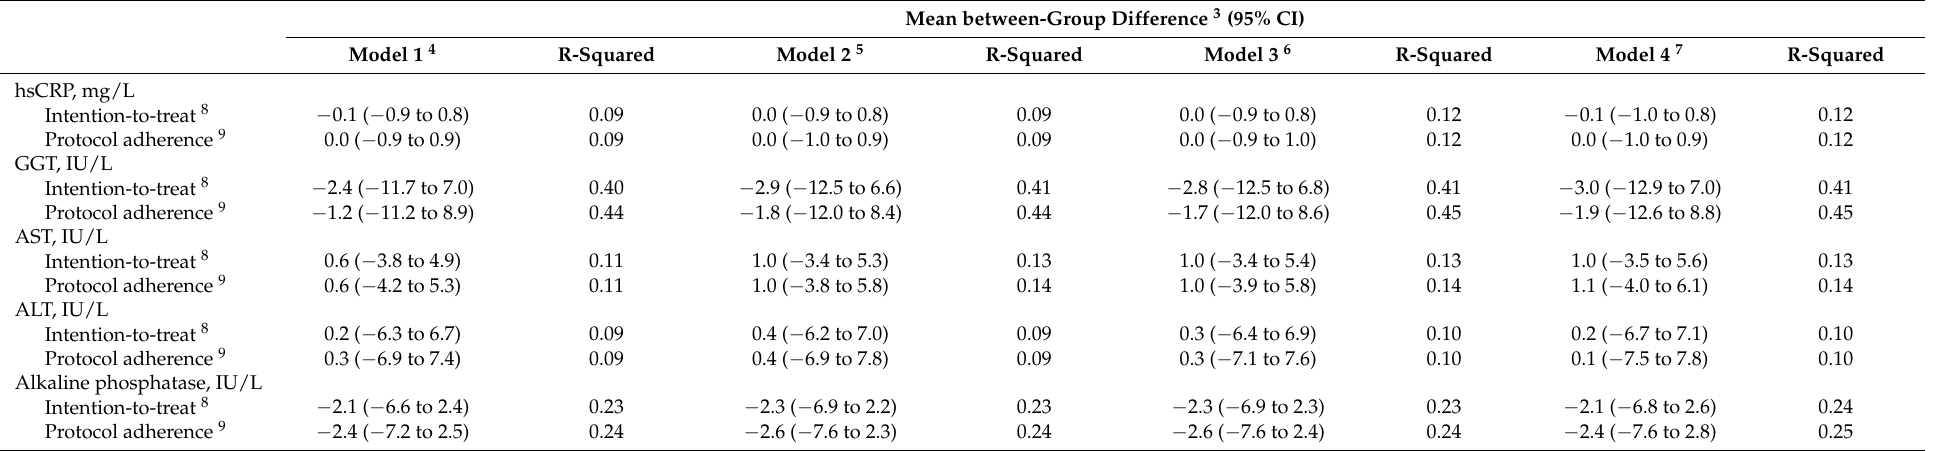
Table 6. Between-group differences of multivariable linear regression models assessing 6-month changes in hepatic function markers related to avocado 1 allotment, per intention-to-treat and per protocol adherence analyses 2